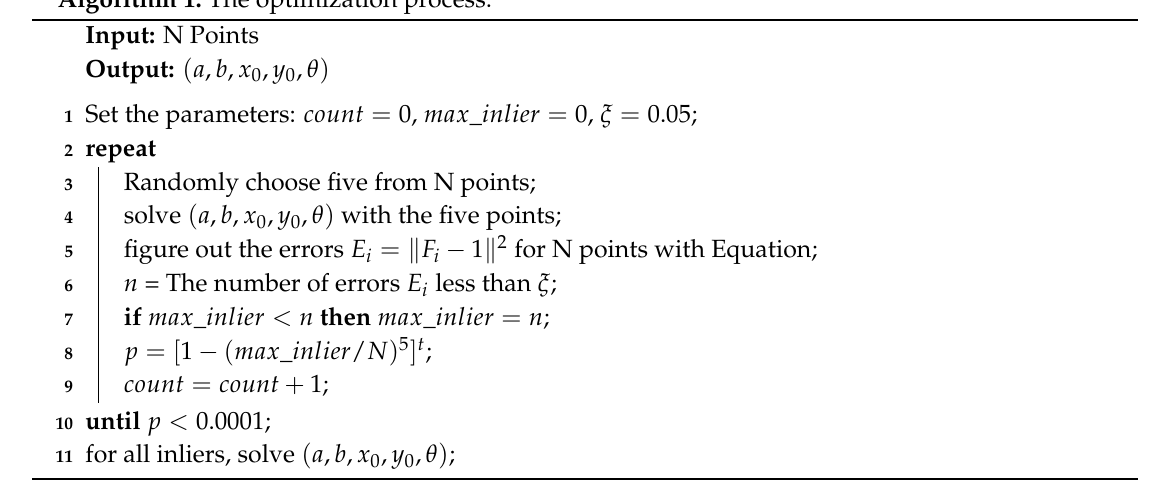
Algorithm 1: The optimization process.